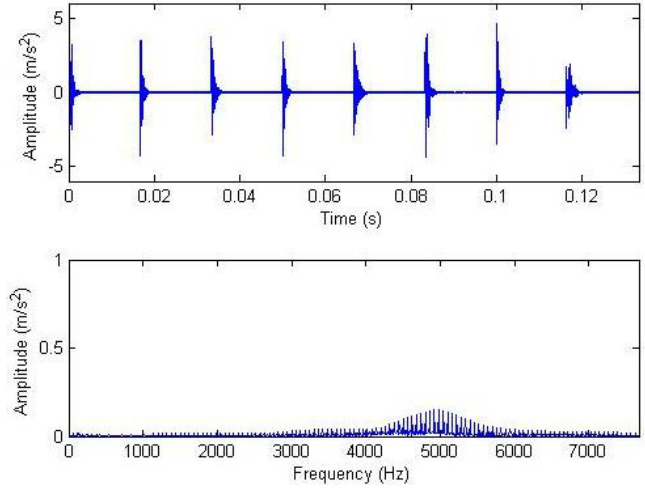
Figure 13. Impulse component with hard threshold (2,048).